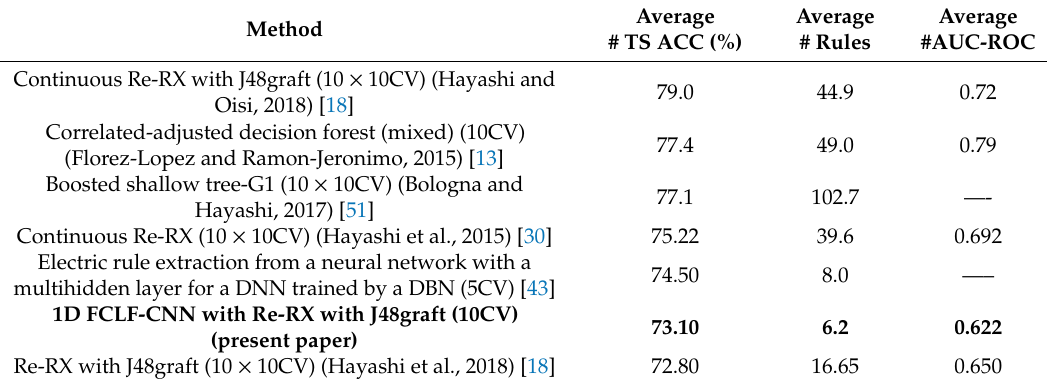
Table 5. Comparison of the performance of recent rule extraction methods and the proposed method (in bold) for the German credit scoring dataset.